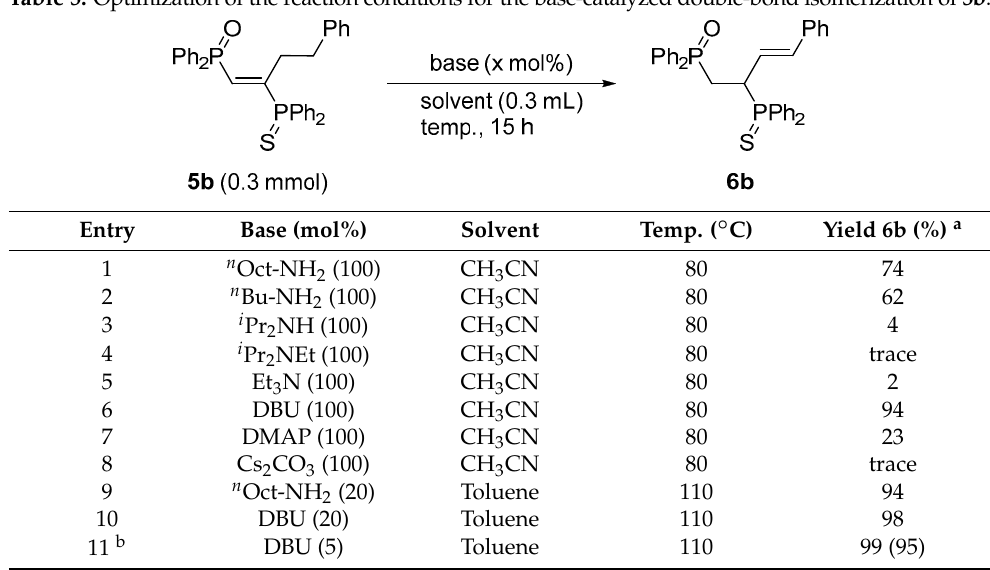
Molecules 2022 , 27 , x FOR PEER REVIEW